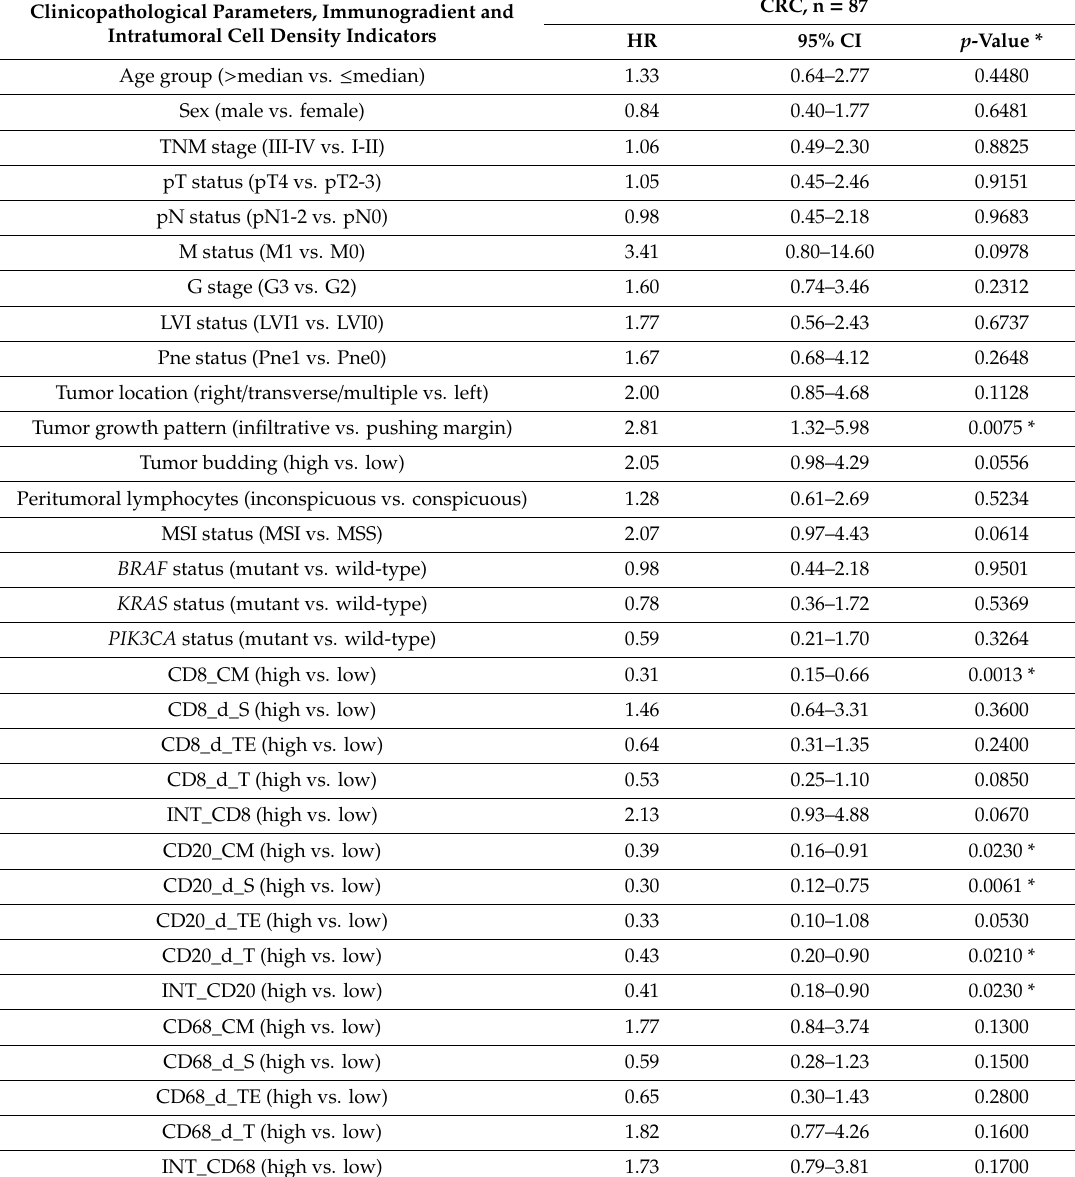
Table 3. Statistics of univariate analyses of clinicopathological parameters, Immunogradient and intratumoral immune cell density indicators for patient overall